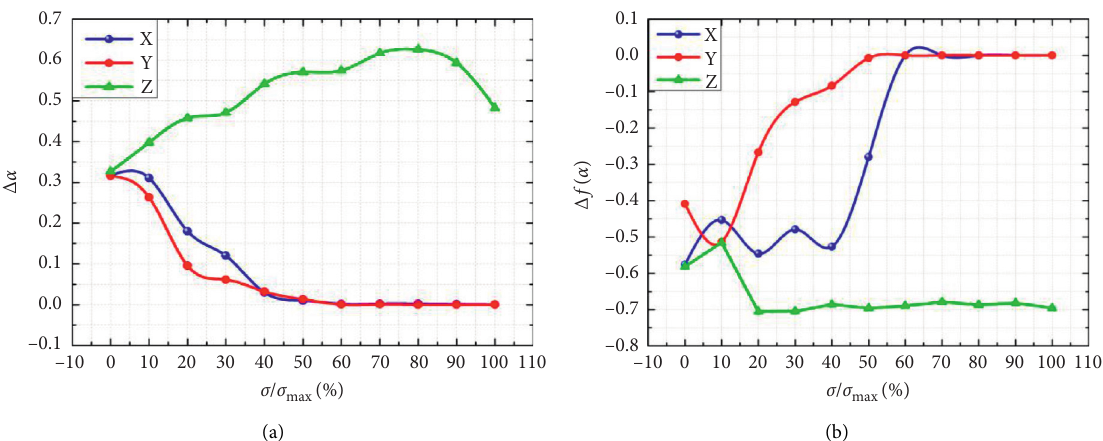
Figure 5: Change of multifractal parameters Δ α and Δ f ( α ) in the different stress stages. (a) Multifractal parameter Δ α . (b) Multifractal parameter Δ f ( α )